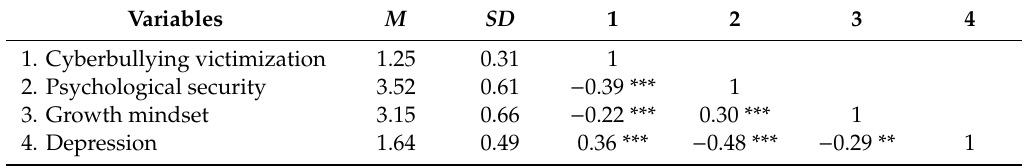
Table 1. Descriptive statistics and correlations among the main variables.